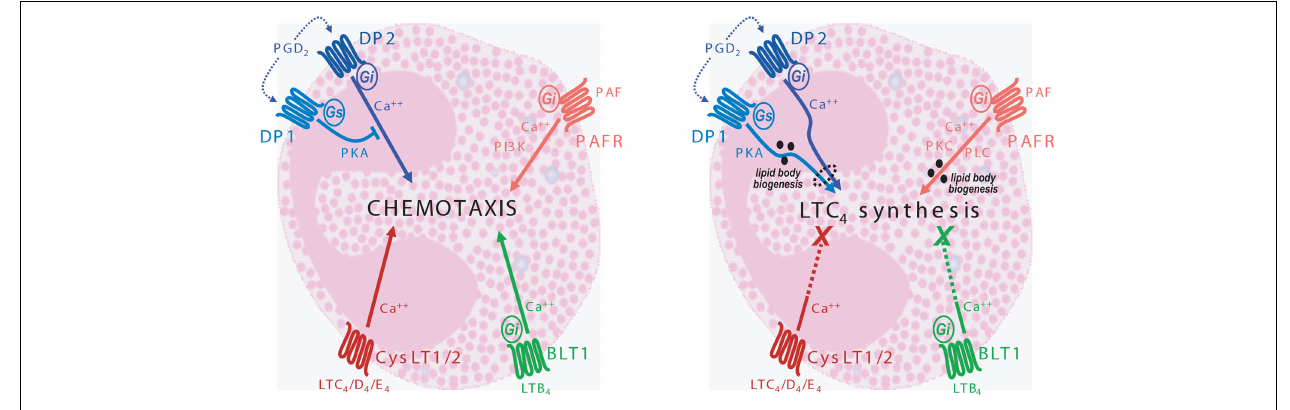
FIGURE 1 | Schematic mechanisms of LTB 4 -, LTC 4 -, PAF-, or PGD 2 -induced eosinophil chemotaxis and LTC 4 synthesis. Left eosinophil scheme displays the ability of the four lipid mediators to trigger eosinophil chemotaxis by activating receptor-mediated distinct intracellular signaling. In contrast, the right eosinophil scheme shows that only PGD 2 and PAF are